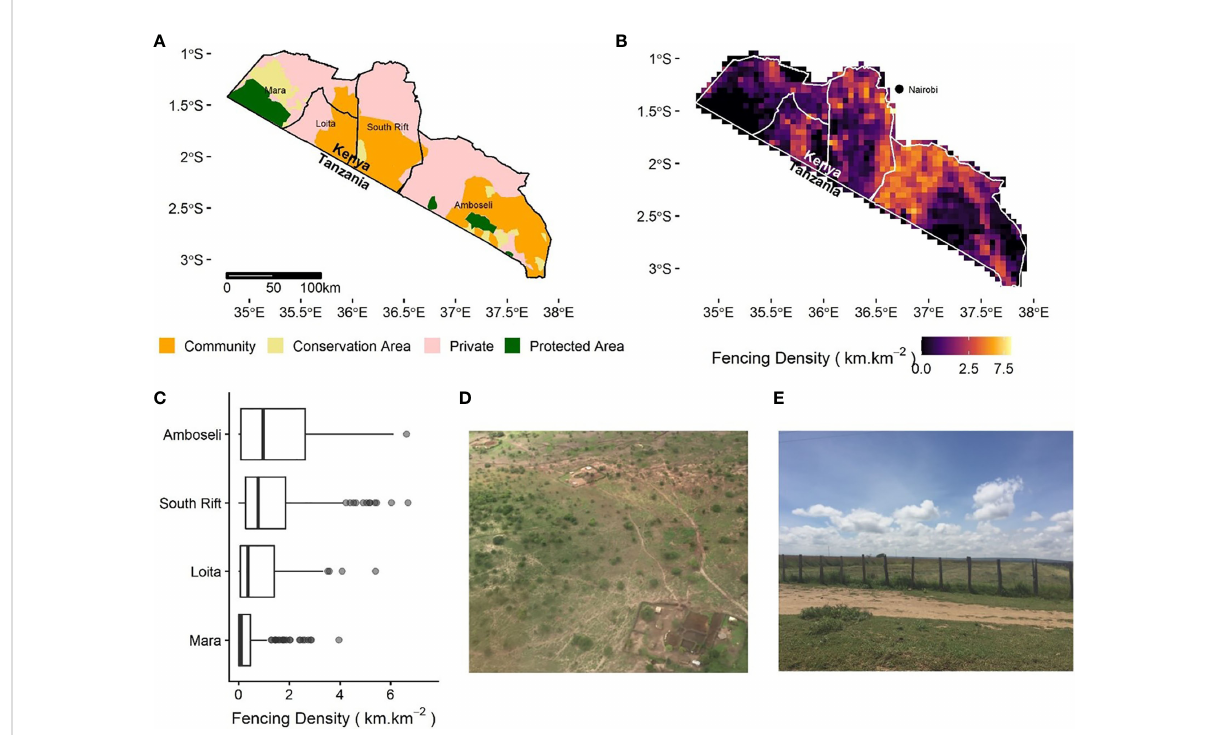
FIGURE 2 (A) The four ecosystems in southern Kenya: Amboseli, South Rift Valley, Loita Hills, and Maasai Mara. Government-protected areas (in green) are shown together with established community and private conservation areas (in yellow); the remaining land is subdivided and individually titled “ Private ” land without conservation efforts (in pink) and collectively owned or managed “ Community ” land (in orange); (B) fence density calculated as km.km -2 calculated on a 0.05-degree grid (~5 km resolution). Nairobi, Kenya ’ s capital city, is displayed for reference; (C) boxplot offence density within each ecosystem, with median (vertical line), fi rst and third quartiles (box) and 1.5 times the interquartile range (whiskers); (D) example of brush fences around settlements; (E) wire and post fencing to demarcate property in the Loita plains (north-east of the Mara